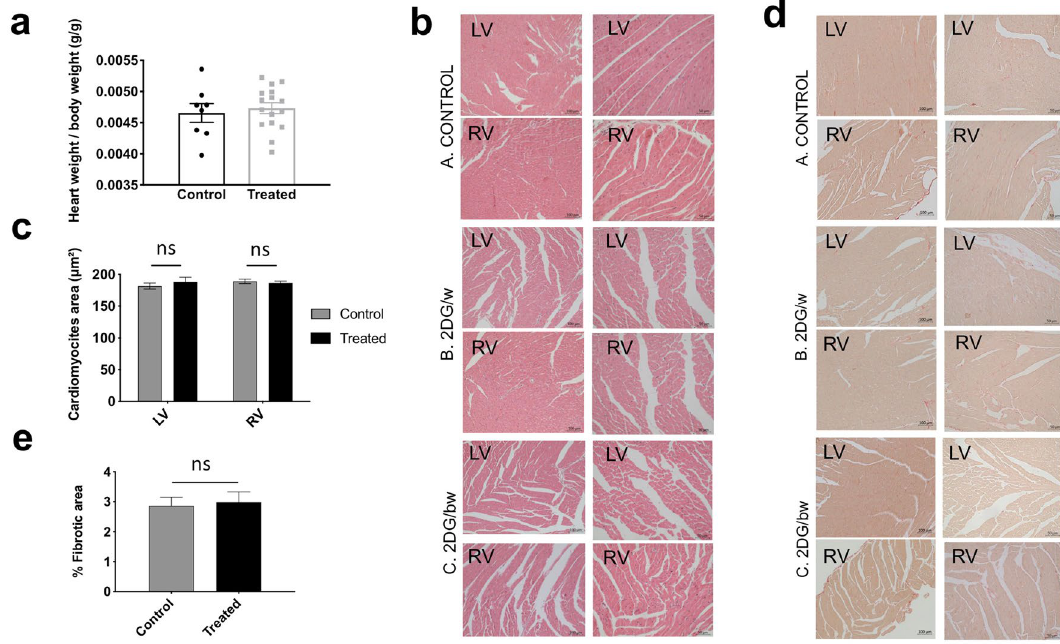
Figure 2. Histological staining indicates normal heart structure in controls and 2DG treated animals with no evidence of fibrosis. ( a) Heart body weight ratio in 8 month old mice treated without (controls) or with 2DG (treated) for 8 months (see methods for details); n = 8 controls; n = 16 treated mice. (b) Heart sections of 4 µm stained with hematoxylin eosin; LV and RV, left and right ventricle respectively. Objective lens 20 × for the left column, 40 × for the right; NA, 0.30. ( c) Quantitative analysis of the longitudinal area of ~ 100 cardiomyocytes from 3 mice per group revealed no significant difference (ns) in fibre size between treated and control animals in either the left (LV) or right (RV) ventricle. ( d) As ( b ) except that the heart sections were stained with picrosirius red to highlight fibrotic fibers. ( e) Quantitative analysis of the fibrotic area of the heart from sections such as those shown in panel ( d) showing no significant difference between control and 2DG treated